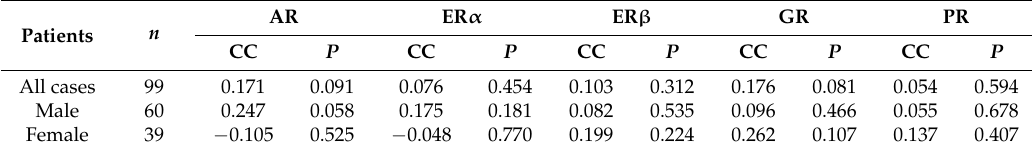
Table 3. Correlations between p-ELK1 and AR/ER α /ER β /GR/PR